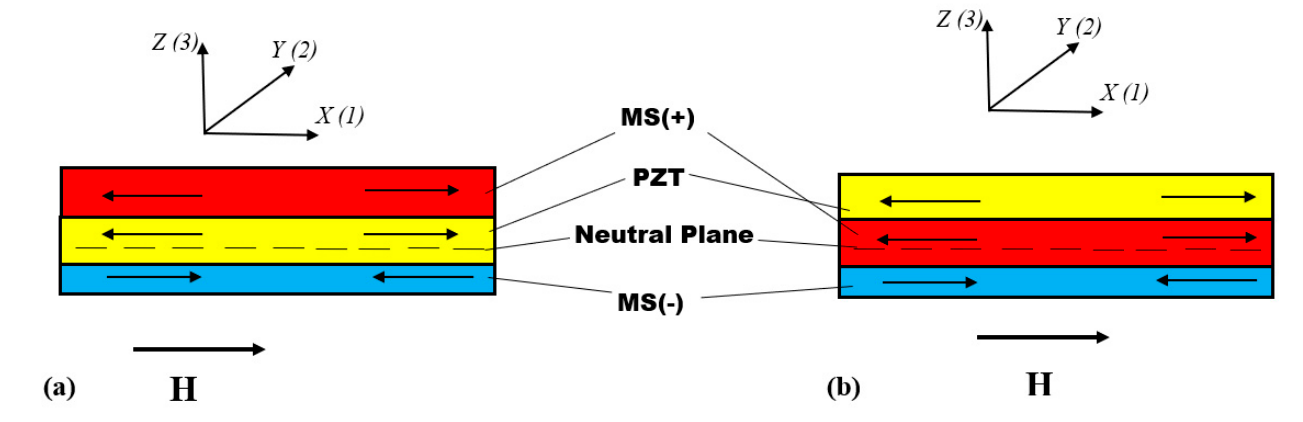
Figure 1. Schematic drawing of ( a ) Type 1 and ( b ) Type 2 asymmetric trilayers, with PZT layer of thickness t p and magnetostrictive (MS) layers with positive (MS+) and negative (MS − ) magnetostriction and thicknesses t m 1 and t m 2 , respectively. The dashed line represents the neutral plane.